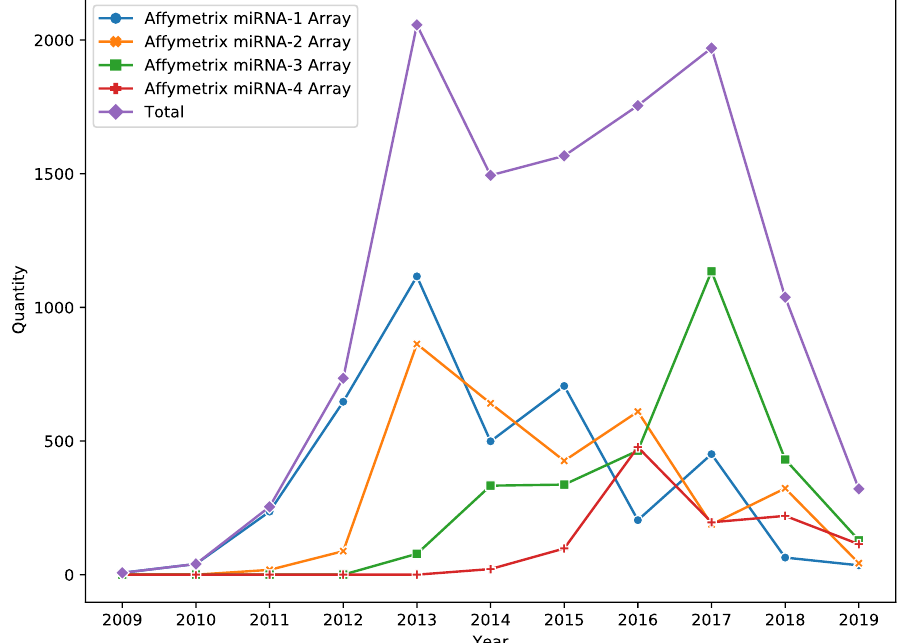
Figure 1. Number of Gene Expression Omnibus (GEO) accessions corresponding to Affymetrix miRNA Array